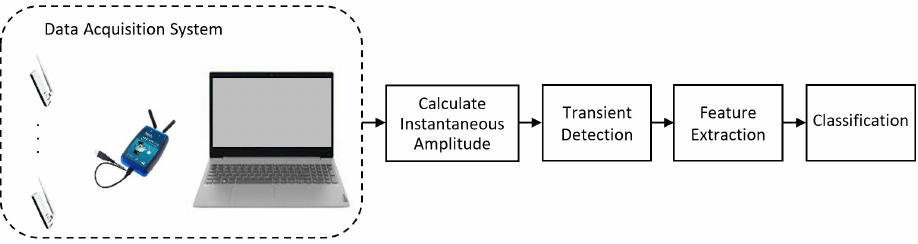
Figure 1. RF fingerprinting-based device identification system block